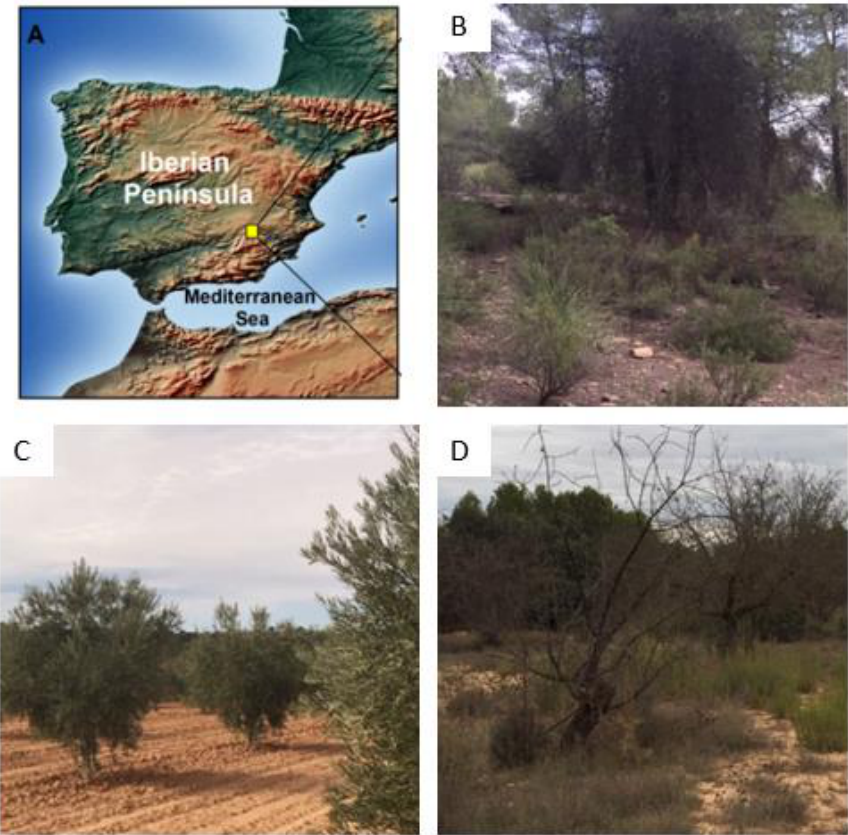
Figure 1. Location of the study area ( A , Villamalea, Castilla La Mancha, SE Spain) with the typical land uses ( B : Forest; C : Intensive agriculture; D : Abandoned farmland).